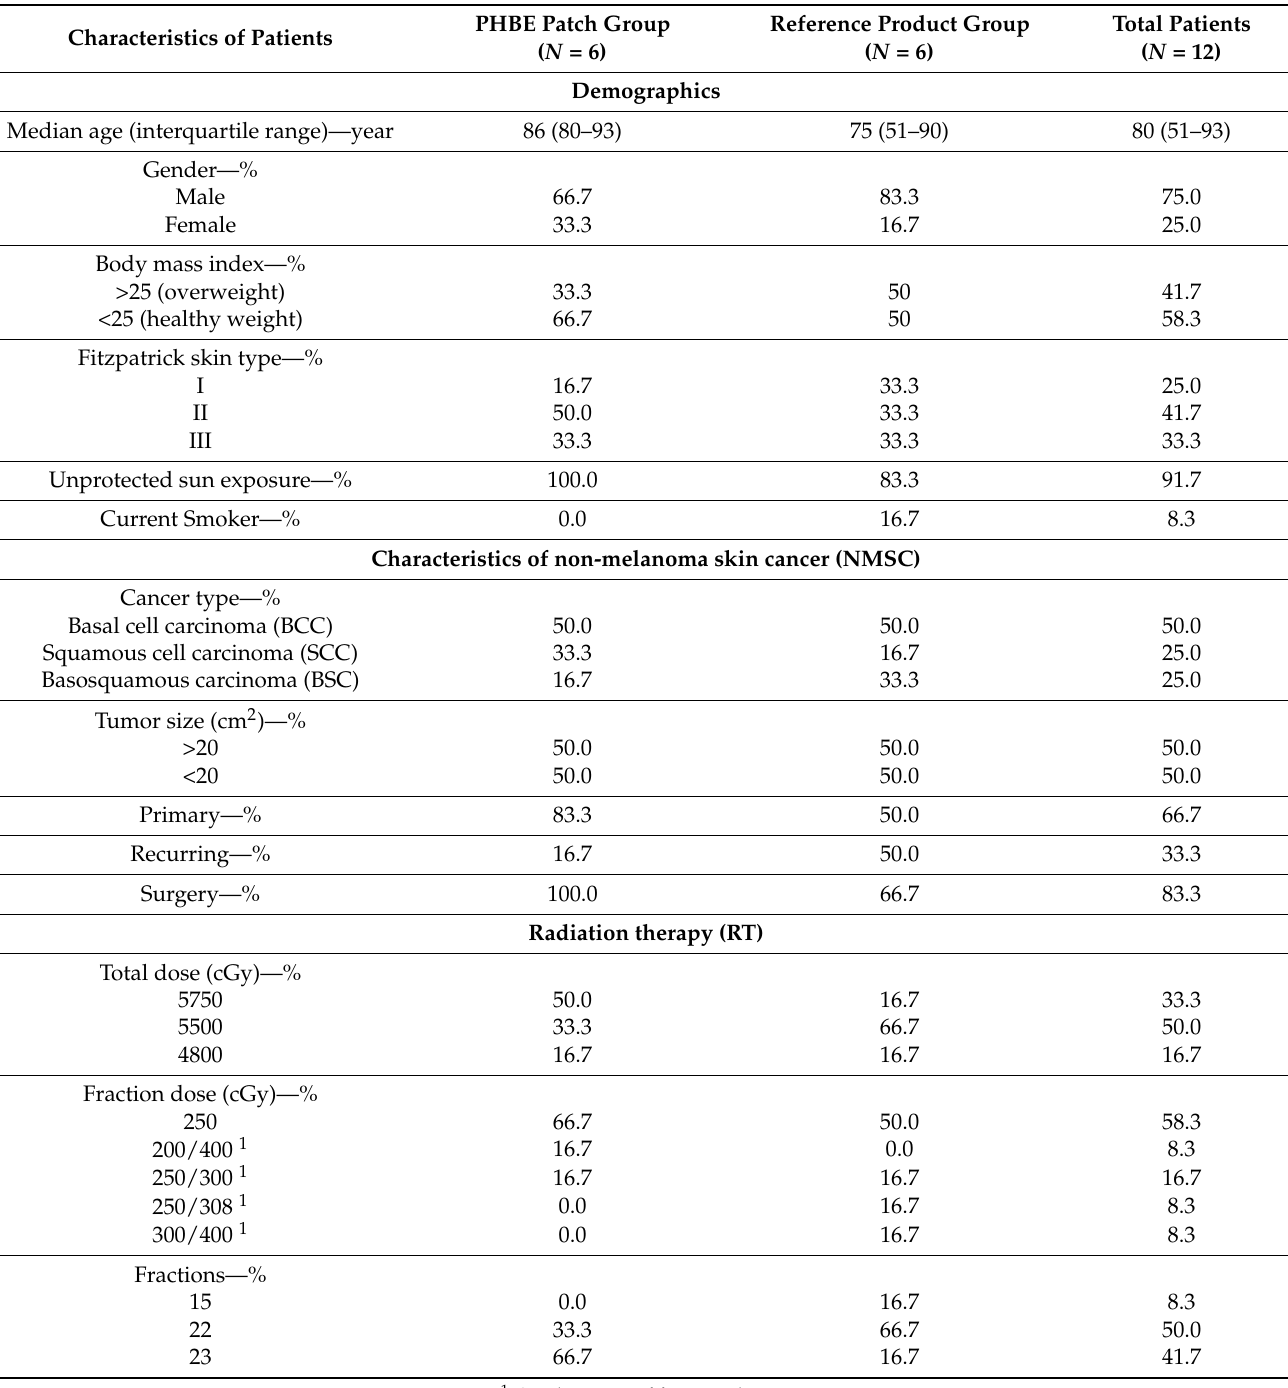
Table 1. Characteristics of the patients at